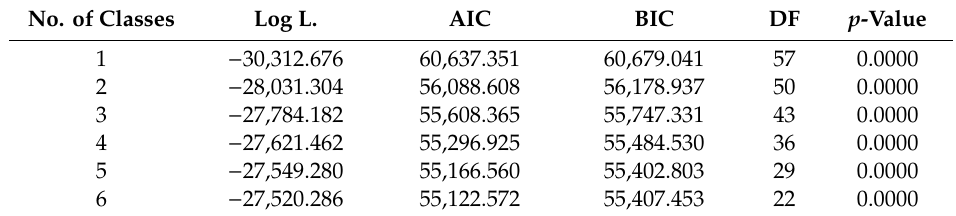
Table 5. Model fit for the optimal number of classes in the latent class analysis (LCA) of parent- child